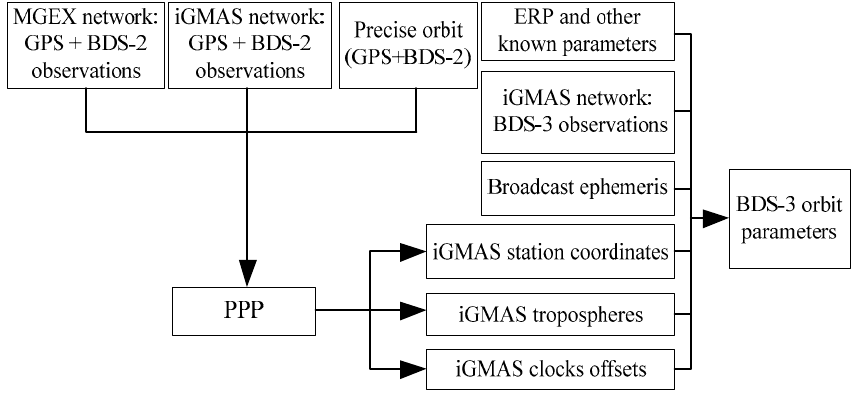
Figure 6. Flowchart of BDS-3 orbit determination based on SS.